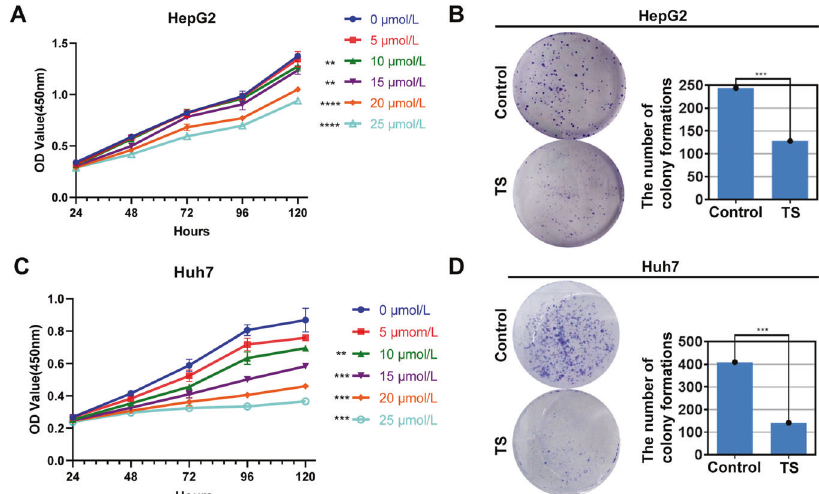
Fig. 1 TS signi fi cantly inhibited the proliferation of hepatoma cells in vitro. A The effect of different concentrations of TS (0, 5, 10, 15, 20 and 25 μ mol/L) on the viability of HepG2 during 24 to 120 h via CCK-8. B The effect of TS (15 μ mol/L) on colony forming ability of HepG2 measured by cell clone formation experiment. C The effect of TS with different concentrations of 0, 5, 10, 15, 20 and 25 μ mol/L on the viability of Huh7 from 24 to 120 h through CCK-8. D The effect of TS (15 μ mol/L) on colony forming ability of Huh7 detected by cell clone formation experiment. Results were obtained from experiments carried out in triplicate from at least three independent experiments. Data are presented as the mean ± SD ( n = 5). * p < 0.05 vs. the Control group; ** p < 0.01 vs. the Control group; *** p < 0.001 vs. the Control